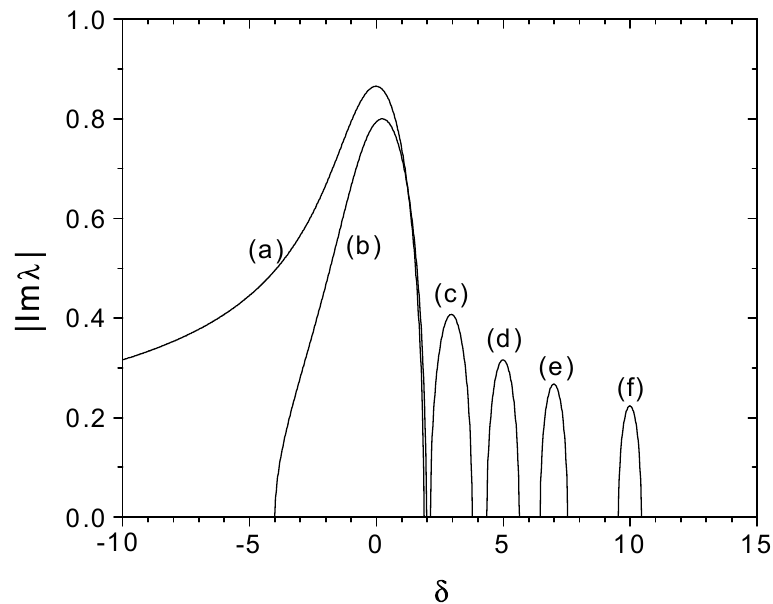
Figure 3. | Im λ | vs. δ and different values of µ : ( a ) 0, ( b ) 0.5, ( c ) 3, ( d ) 5, ( e ) 7 and ( f )